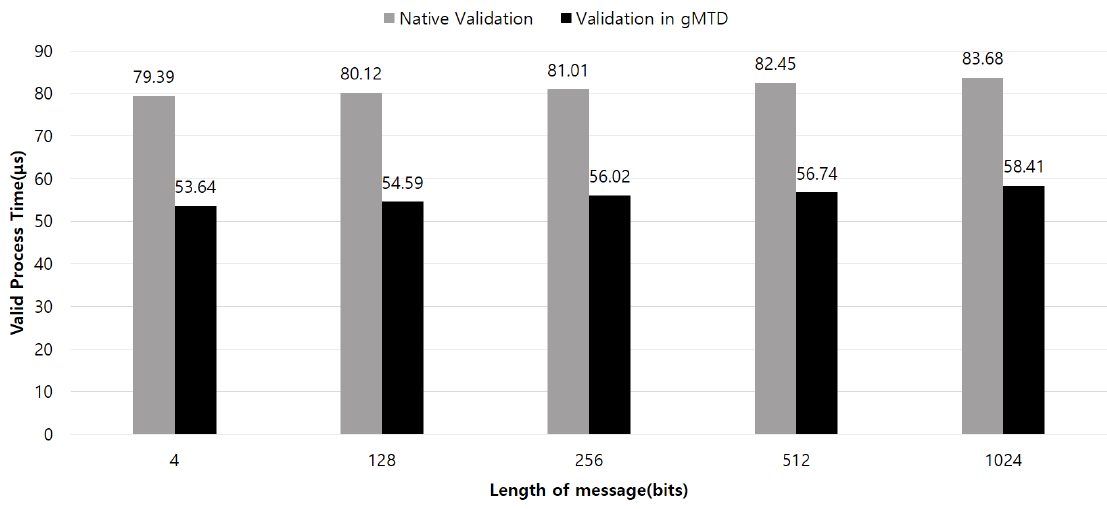
Figure 5. Measuring the validation process time with varying message length.